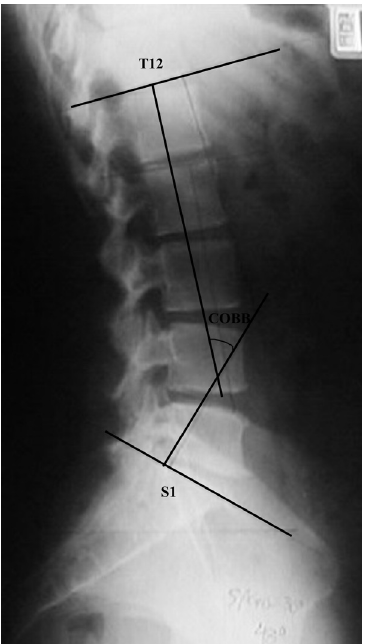
Figure 1 - Total lumbar lordosis angle determined by Cobb’s method, using the intersection of lines at the level of the inferior plateau of T12 and the superior plateau of